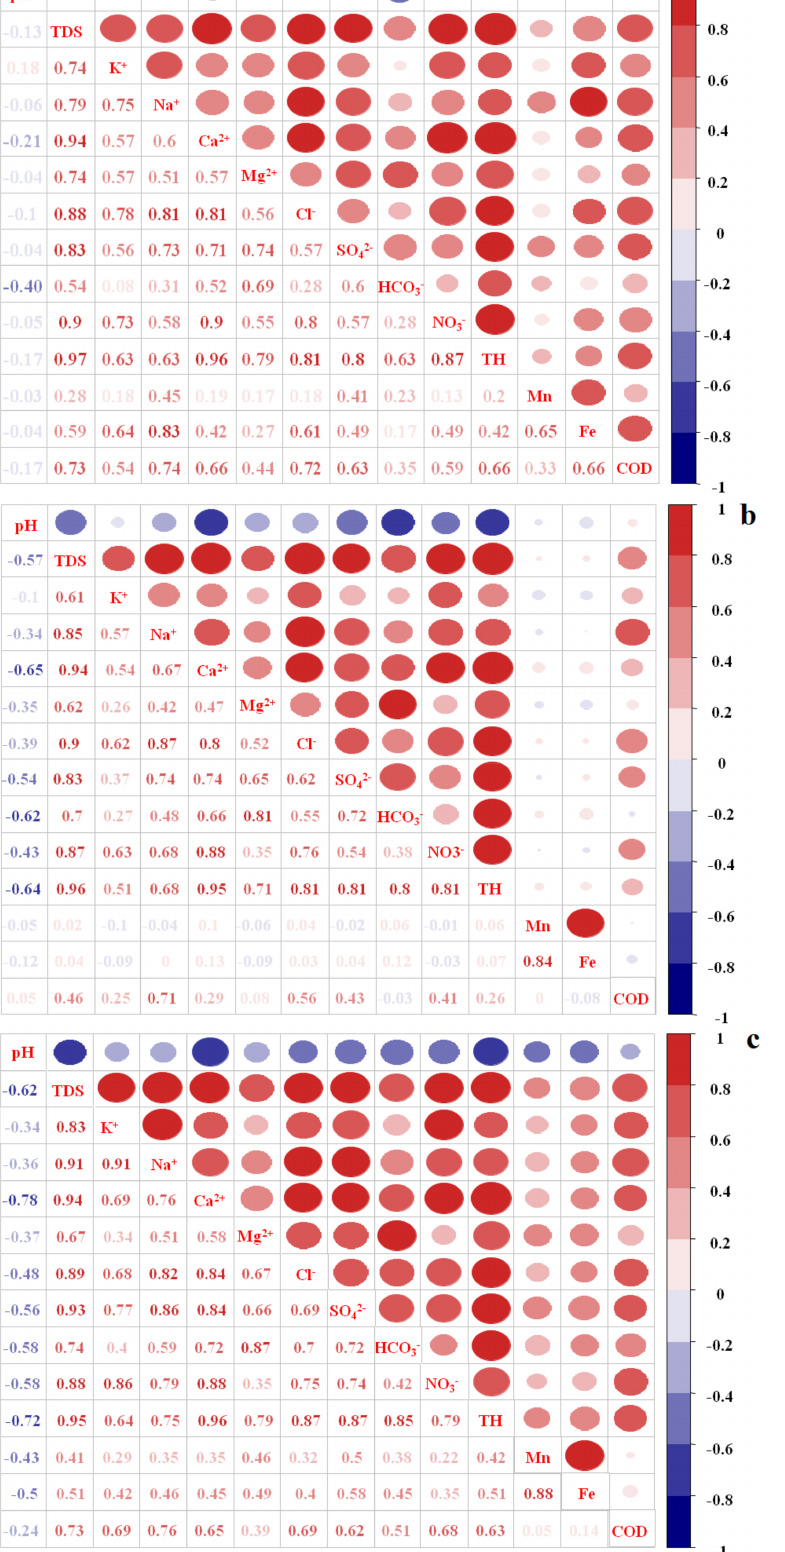
Figure 3. Pearson’s correlation matrix of physicochemical and hydrochemical parameters of groundwater samples in the dry season ( a ), transition season ( b ) and rainy season ( c